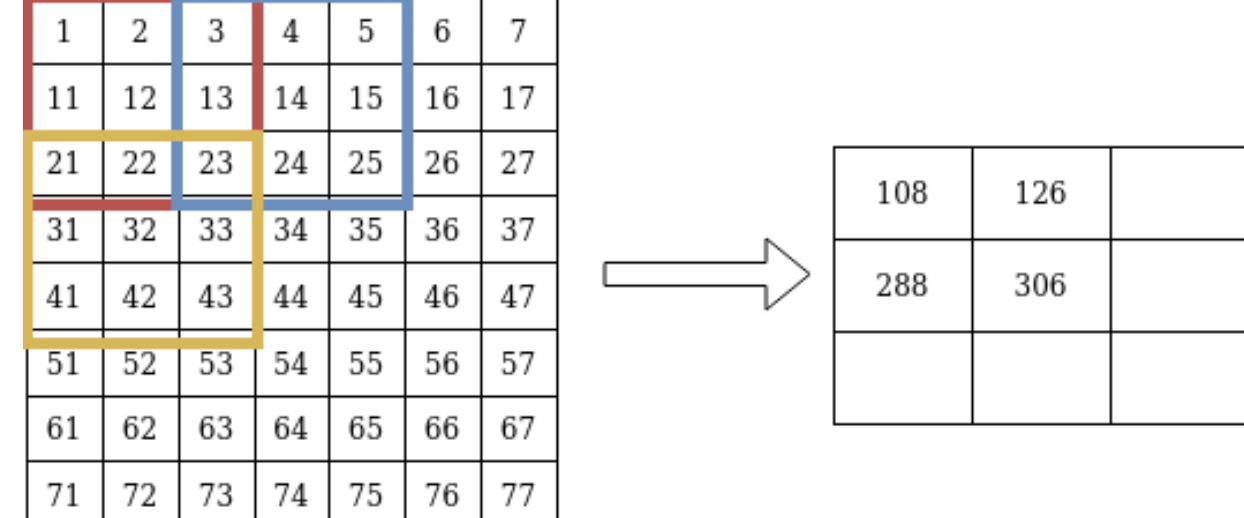
Figure 4. Convolution operation with filter 3*3 with stride 2